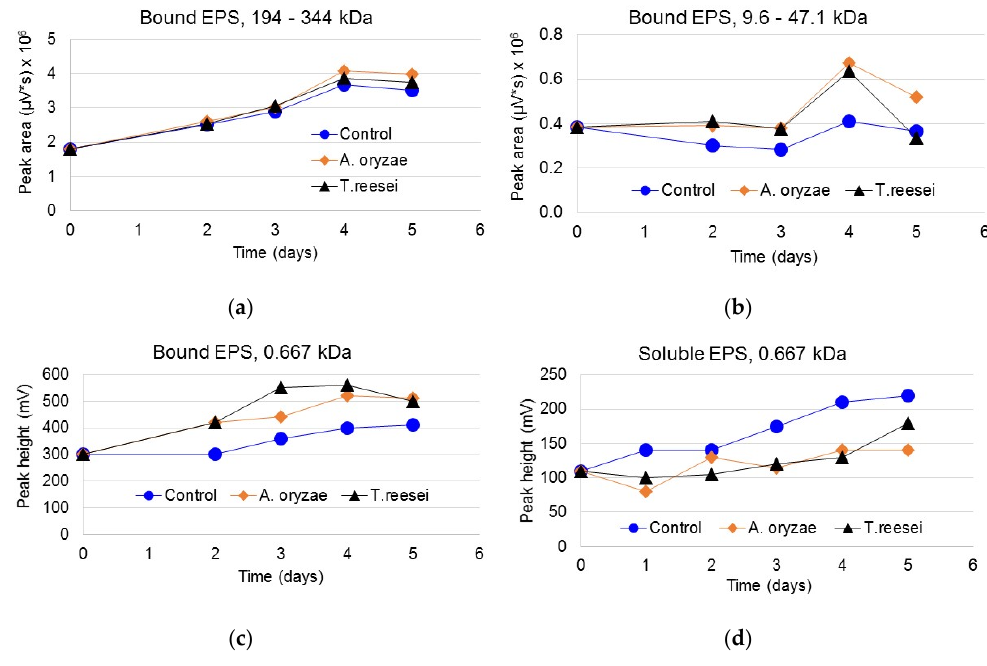
Figure 5. Qualitative determination of polysaccharides in EPS extracts. ( a ) bound EPS, 194–344 kDa; ( b ) bound EPS, 9.6–47.1 kDa; ( c ) bound EPS, 0.667 kDa; ( d ) soluble EPS, 0.667 kDa.